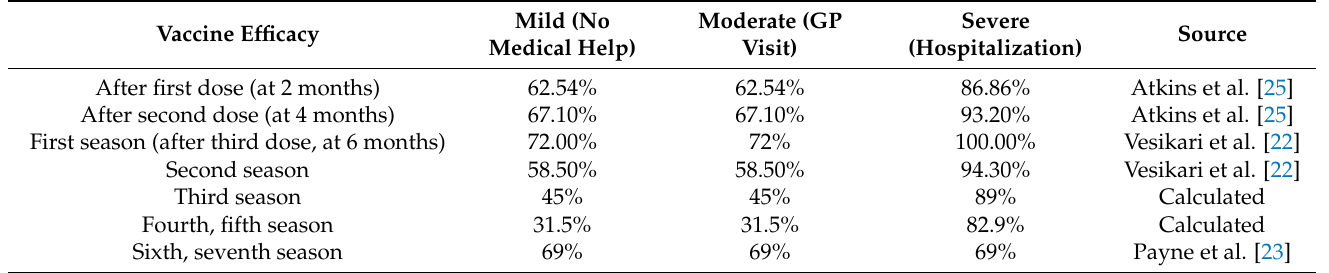
Table 5. Vaccine